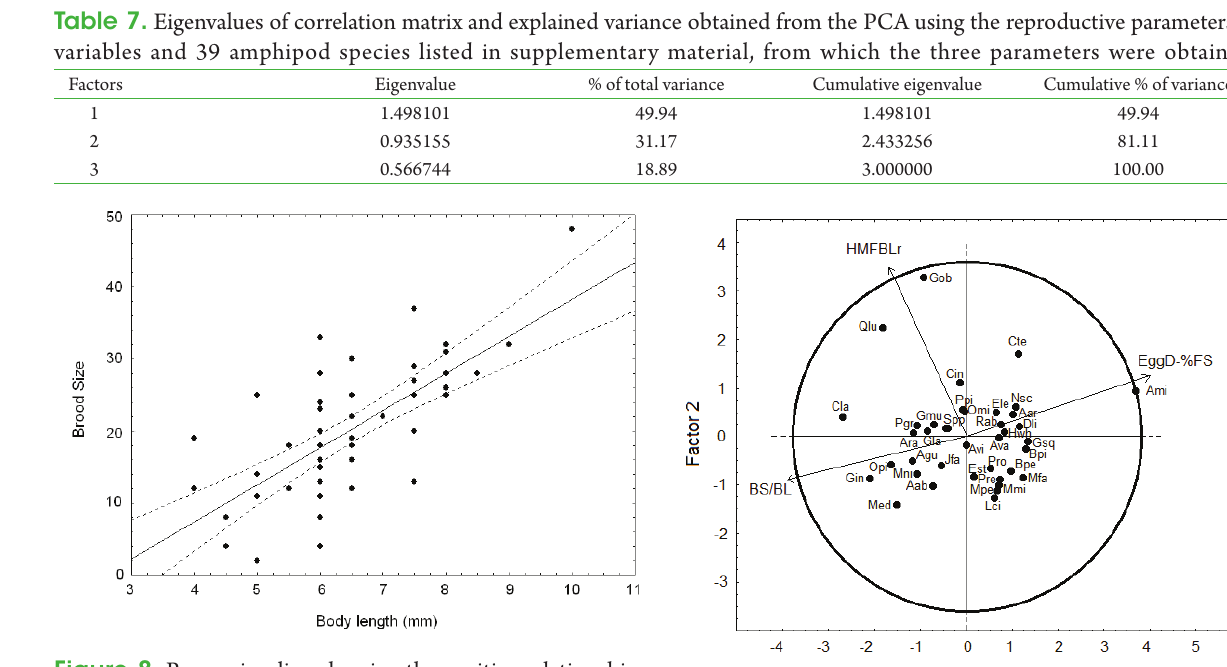
Figure 8. Regression line showing the positive relationship between brood size and body length in the amphipod Quadrivisio lutzi .